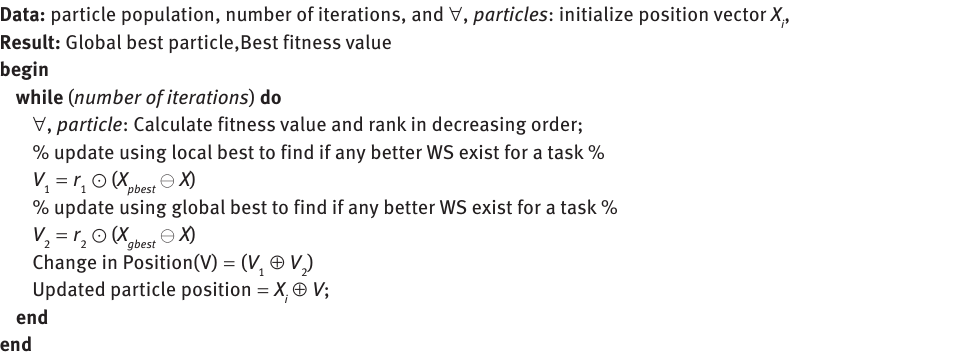
Algorithm 4: Discrete PSO for WS